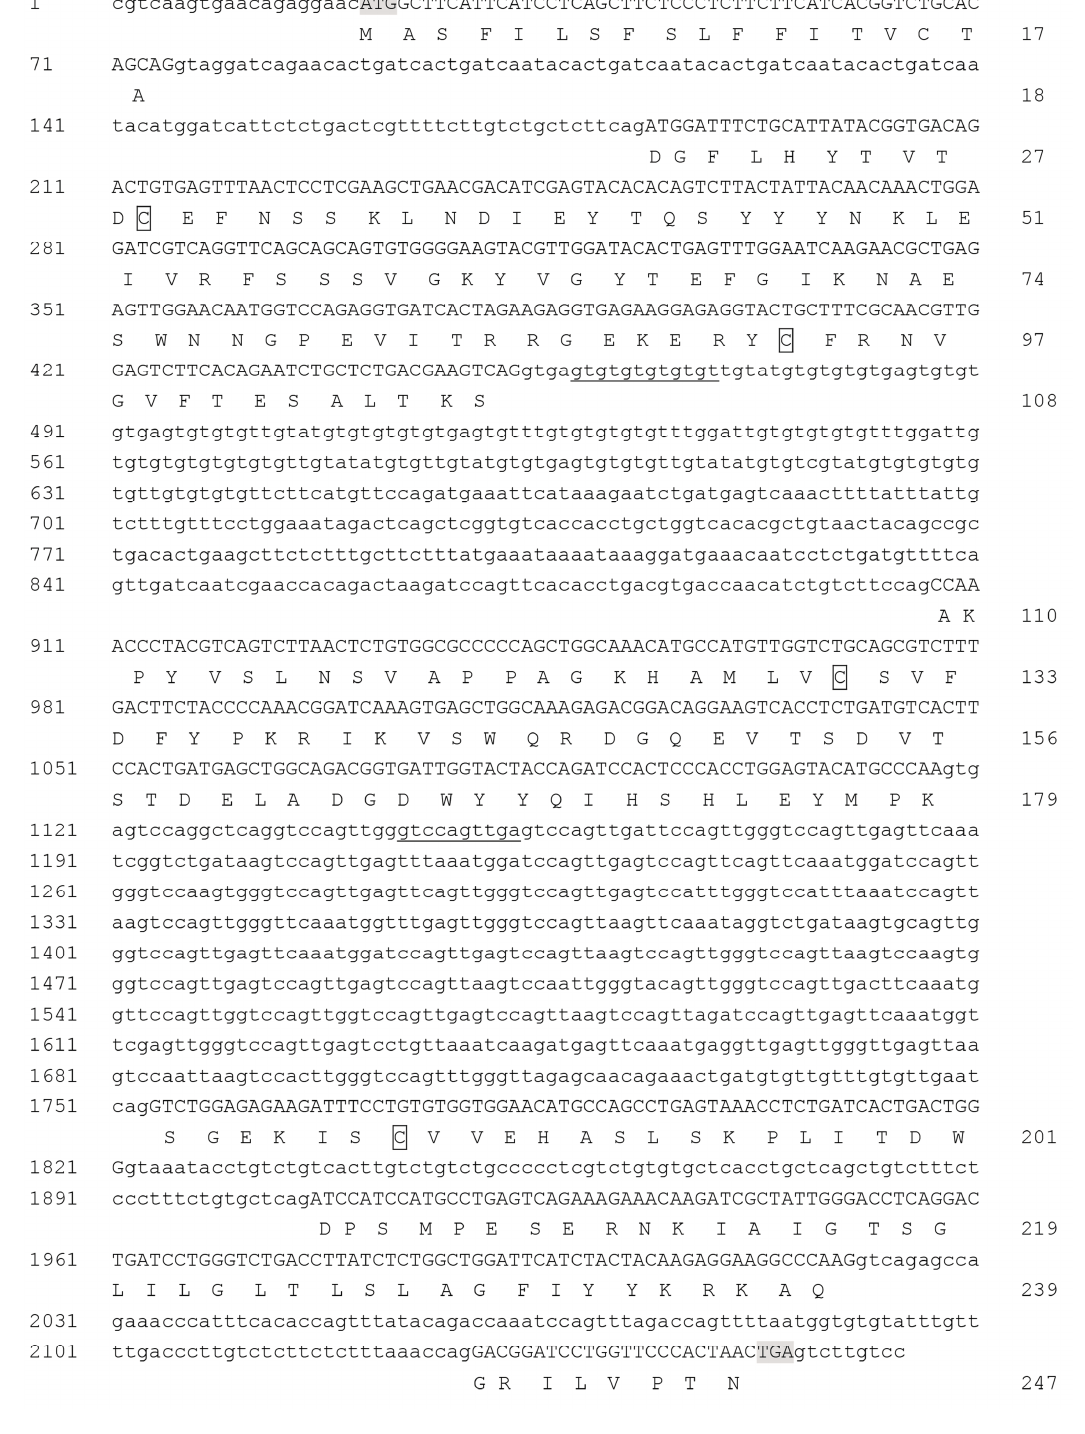
Figure 5. DNA sequence and putative amino acid sequence of the Japanese flounder MHC class II B . The intron sequences are in lowercase letters and the exon sequences in DNA are in uppercase letters. The amino acid sequences encoded by the open reading frame (ORF) are in uppercase letters below the exon sequences. The translational initiation codon and termination codon are in shade. Four cysteines are boxed. The start of GT repeat in intron 2 and the decamer repeat GTCCAGTTGA in intron 3 are